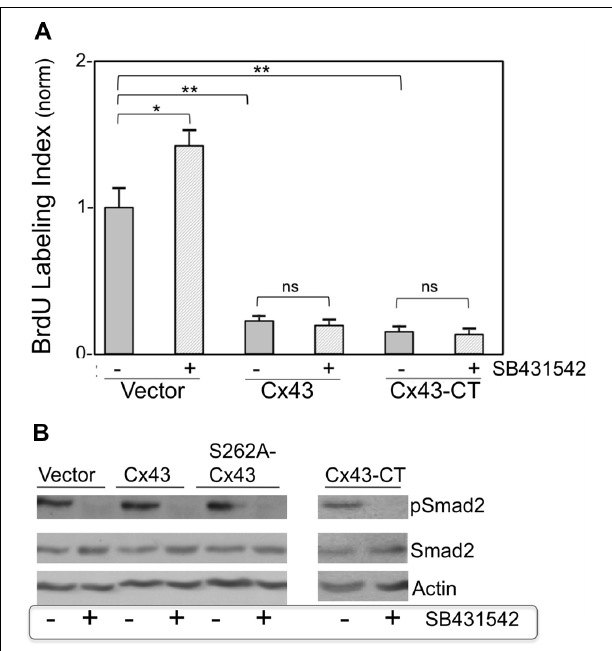
FIGURE 3 | (A) Pharmacological inhibition ofTGF β RI does not affect suppression of DNA synthesis by overexpressed Cx43 or Cx43-CT.The y -axis shows normalized BrDU labeling index of cardiomyocytes transduced either with an empty adenoviral vector, or adenoviral vectors expressing Cx43, or channel-domain-deficient Cx43-CT, and subjected (or not) to SB431542 treatment (indicated by + or –, respectively). Comparisons between groups are indicated by brackets (* P < 0.05, two-way ANOVA, n = 24; data are mean + SEM). (B) Smad2 activity (pSmad2), or its inhibition by SB431542, are not affected by overexpression of Cx43, S262A-Cx43, or Cx43-CT.Western blots (representative of n = 2) showing the effect of ± SB431542, on pSmad2, and total Smad2, in myocytes transduced either with an empty adenoviral vector (Vector) or with adenoviral vectors expressing Cx43, S262-Cx43, or Cx43-CT, as indicated. Expression of the transduced genes was verified by western blotting or immunofluorescence (data not shown).